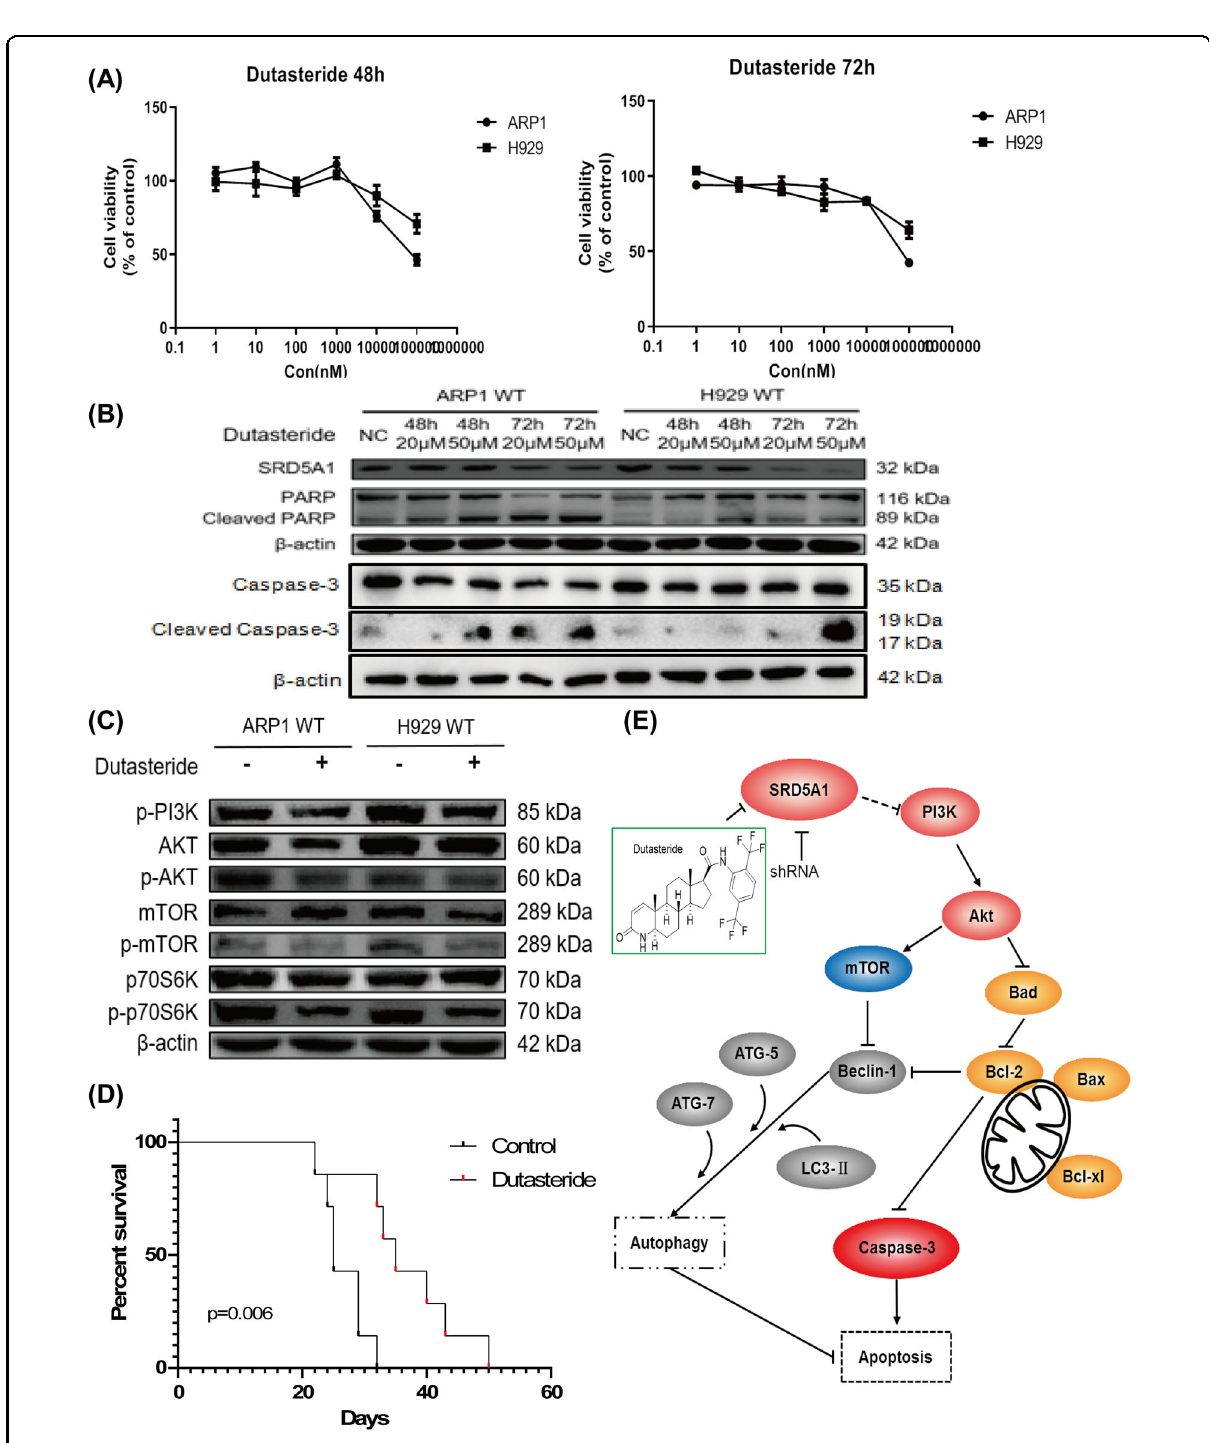
Fig. 7 Dutasteride possesses a therapeutic effect on MM. A MTT proliferation assay of ARP1 and H929 cells treated with different concentrations of dutasteride for 48 or 72 h. B Expression of apoptosis markers in dutasteride-treated ARP1 and H929 cells as determined by western blotting analysis. C Western blotting showed that Dutasteride treatment inhibited the activity of PI3K/Akt/mTOR signaling in ARP1 and H929 cells. D An MM model was established by injecting 8-week-old C57BL/KaLwRij mice with intravenous 5TMM3VT via the tail vein (1 × 10 6 cells per mouse; n = 7 per group). The survival curves of the 5TMM3VT mouse model with or without Dutasteride treatment are presented. E The model of our working hypothesis. Reduced SRD5A1 expression triggers apoptosis and autophagy activation eventually leads to cell death when autophagy cannot compensate for apoptosis-induced cellular